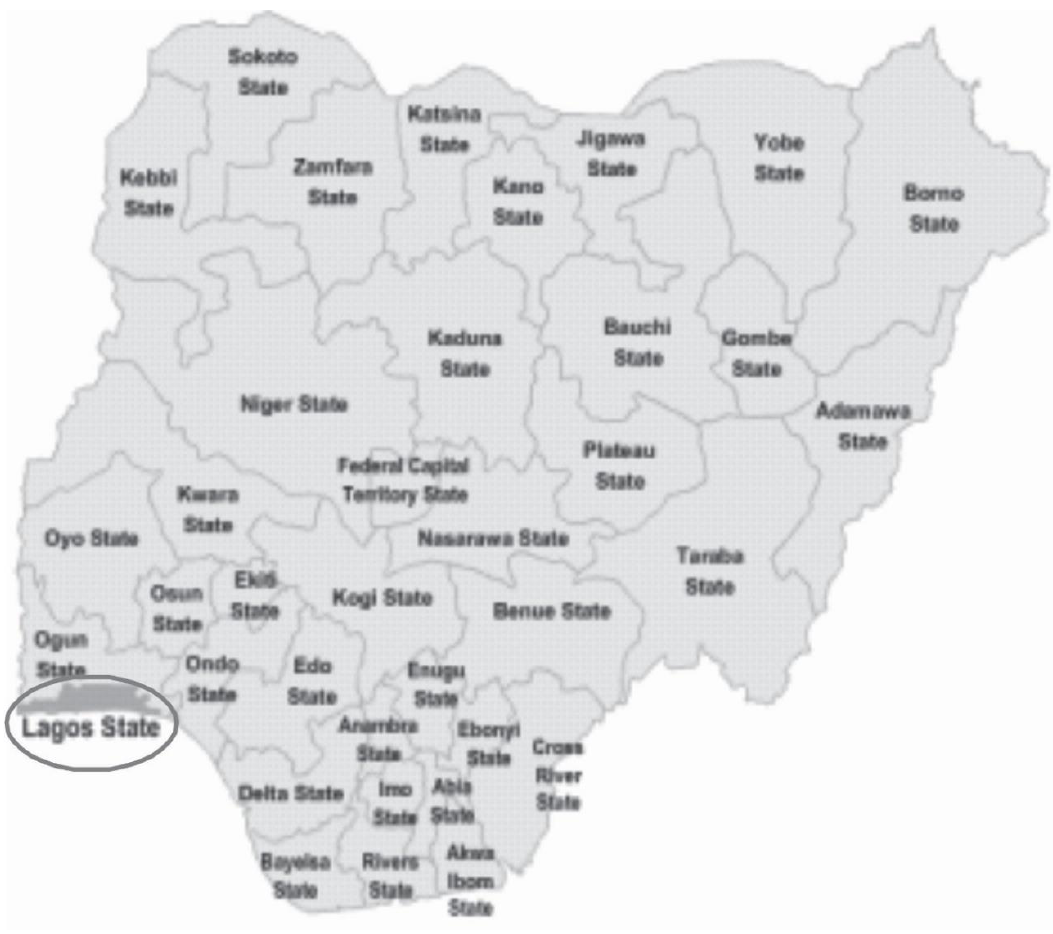
Fig. 4. Map of Nigerian, showing the location of Lagos (Source: www.google.com.ng